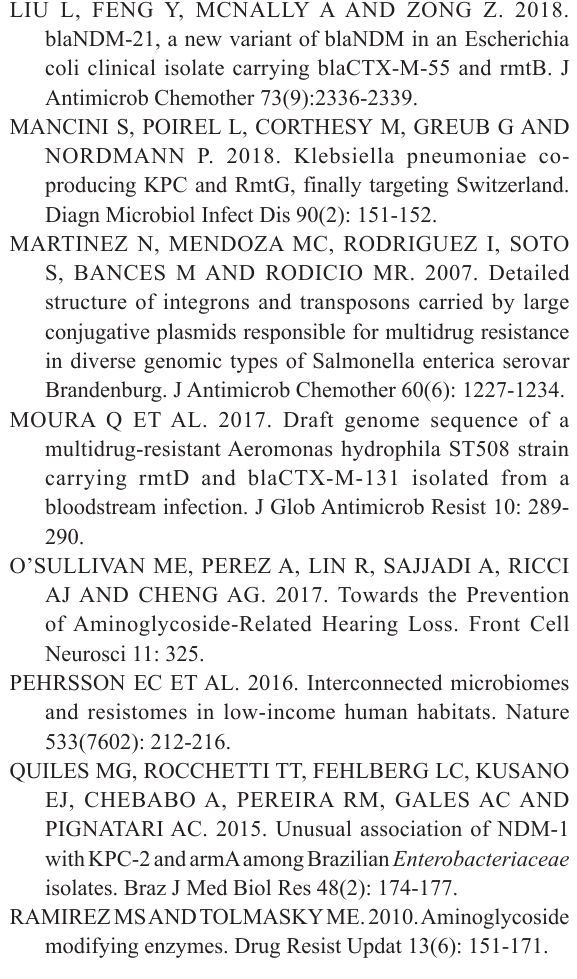
Table SI - Resistome Analysis of Klebsiella aerogenes